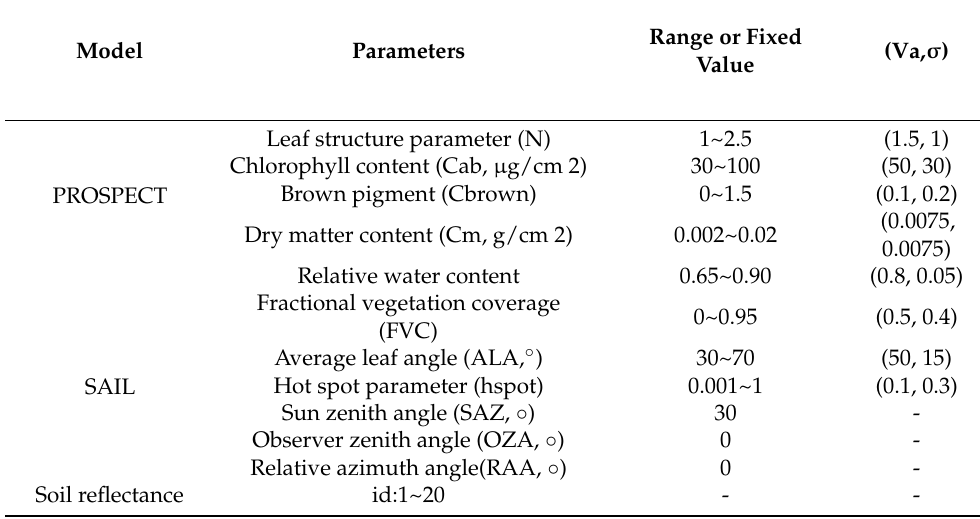
Table 4. Input parameters for the PROSAIL